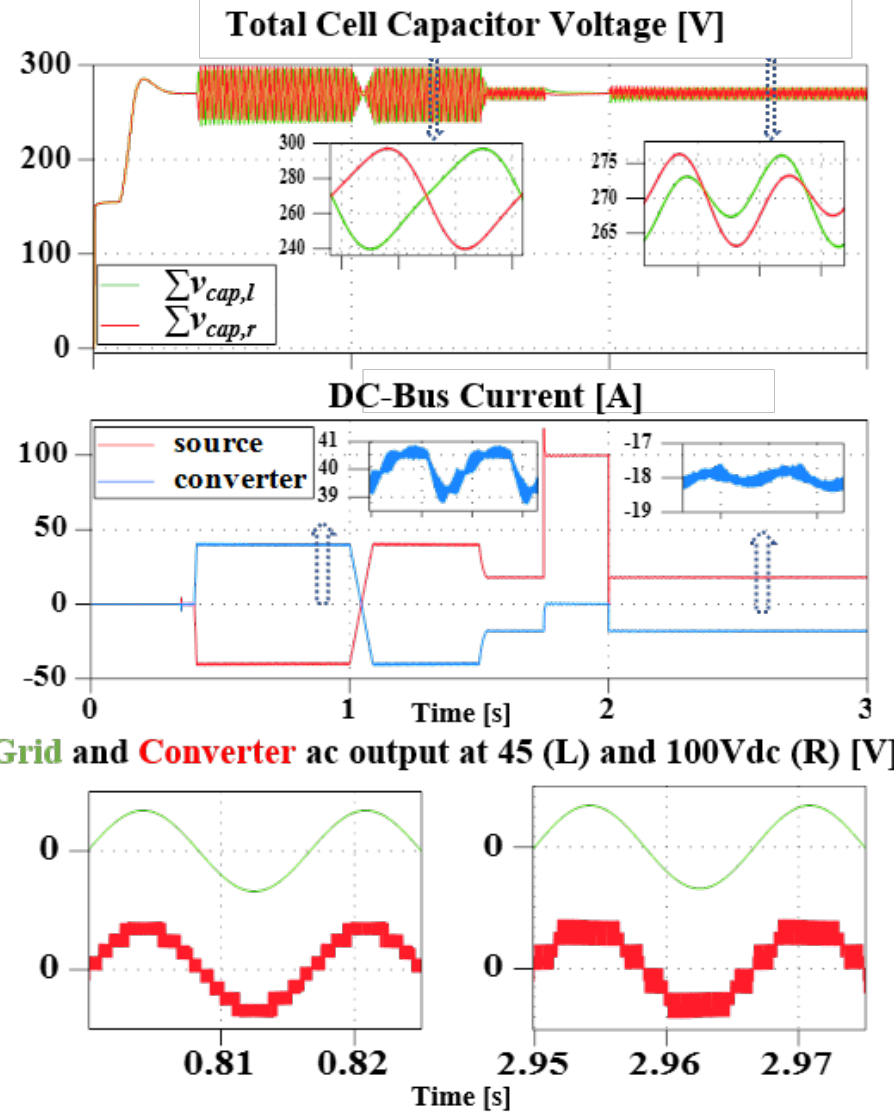
Figure 6. Simulation result showing the total left and right arm cell capacitors voltage, DC-side currents (both the source and the converter) during transients and steady-state, as well as the grid and converter AC output voltage during 45 V ( Left ) and 100 V ( Right ) DC-bus